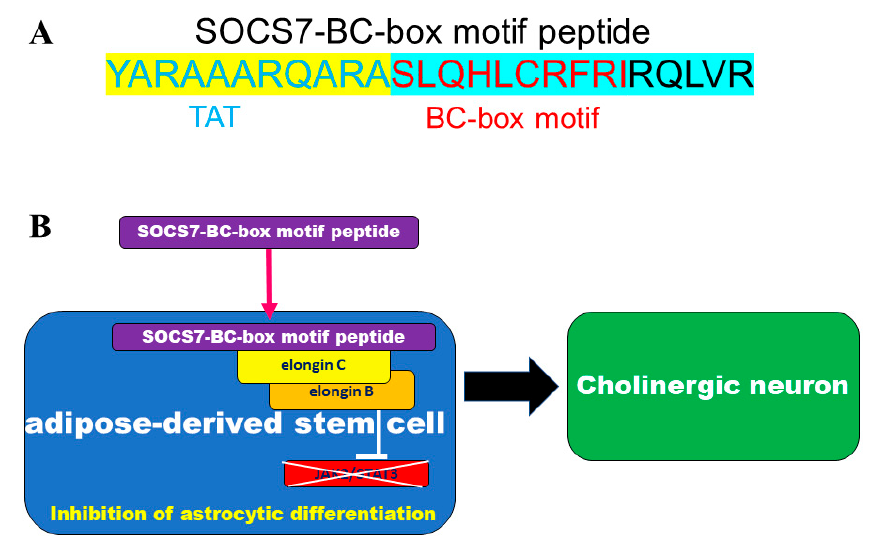
Figure 7. ( A ) Structure of protein transduction domain (TAT)-conjugated SOCS7-derived-BC box motif peptide. ( B ) Molecular mechanism of SOCS7-derived BC-box motif peptide-mediated neu-